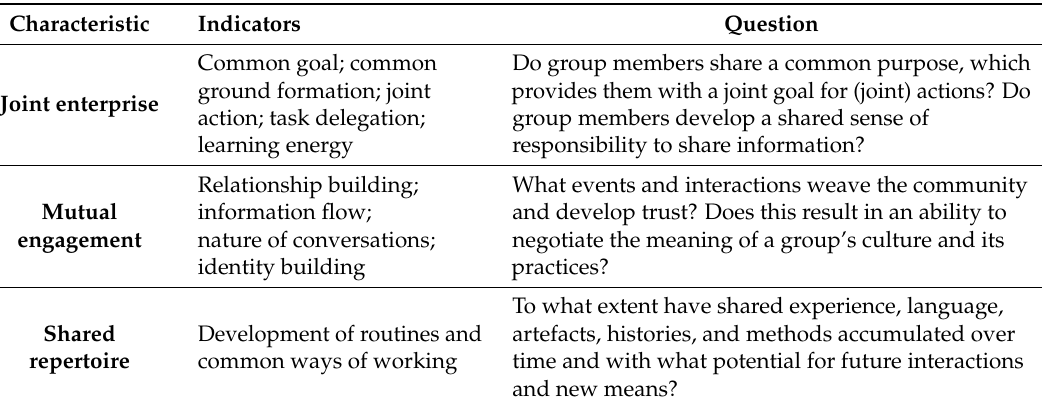
Table 1. Conceptual